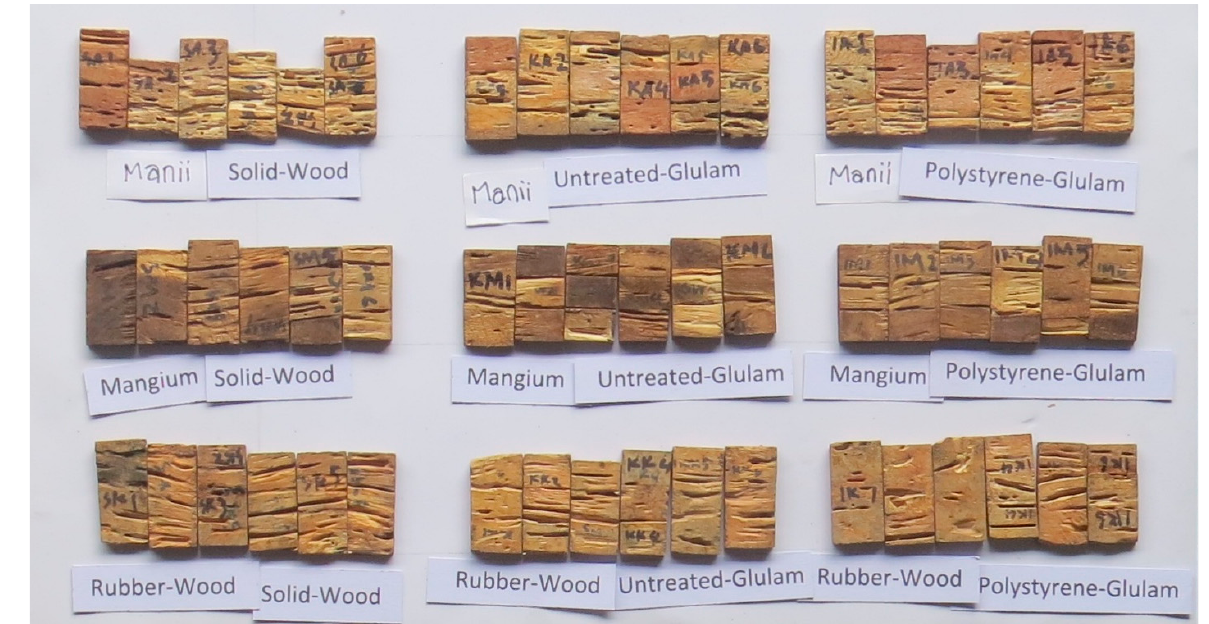
Figure 3. Wood specimens after the laboratory test.